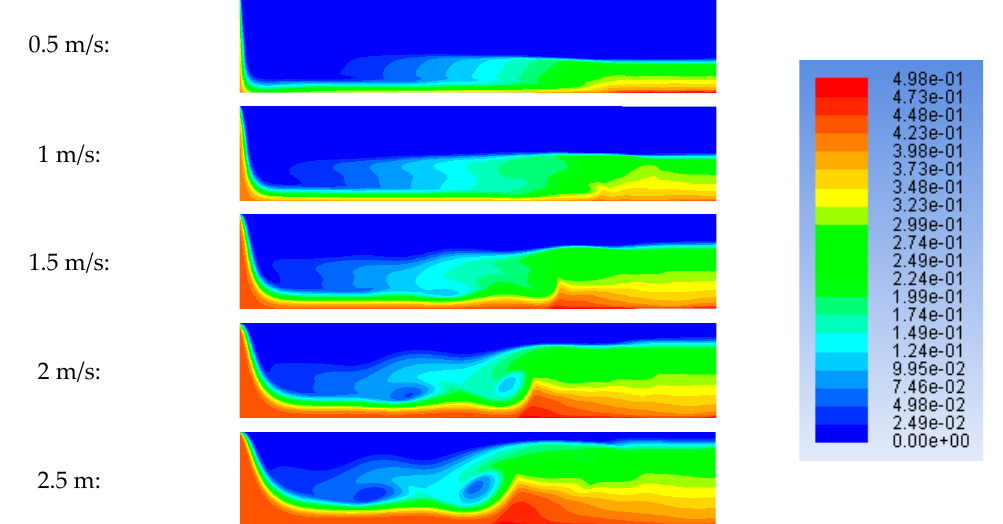
Figure 7. Gravel settlement diagram with different fluid velocity.